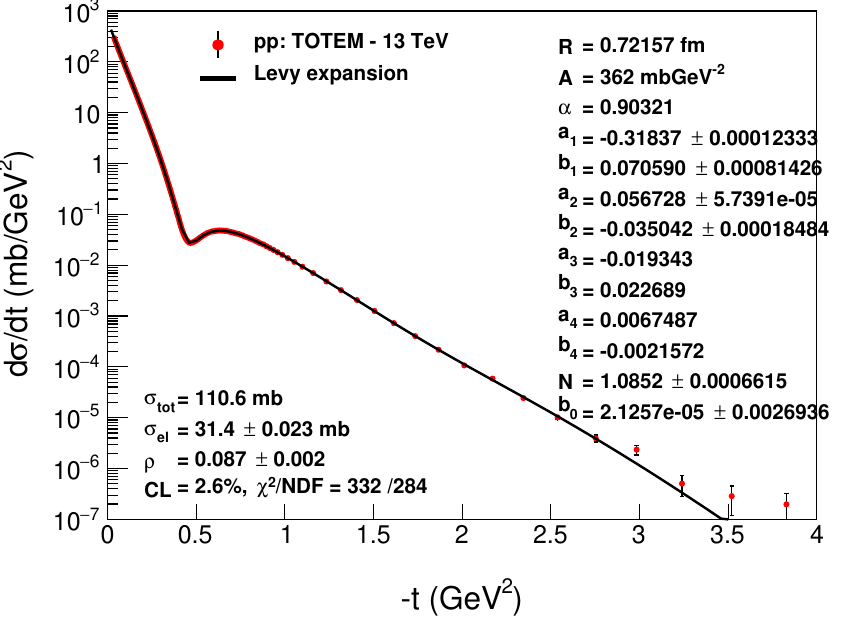
Figure 1. Fourth order Levy expansion to √ s = 13 TeV pp elastic scattering data using Eq. (1) with a b 0 as a free parameter. The comparision to the TOTEM data from Ref. [6] resulted in a statistically acceptable description within quadratically added statistical and systematic errors. The fit parameter b 0 was within errors found to be zero, hence it was fixed to zero in the subsequent